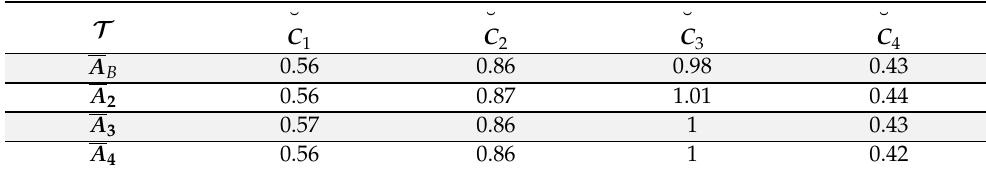
Table 15. Matrix in which we find the value of T.